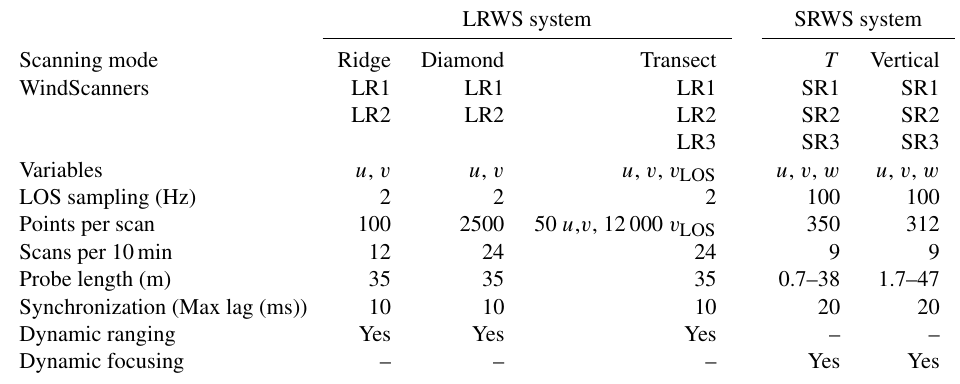
Table 4. Scanning